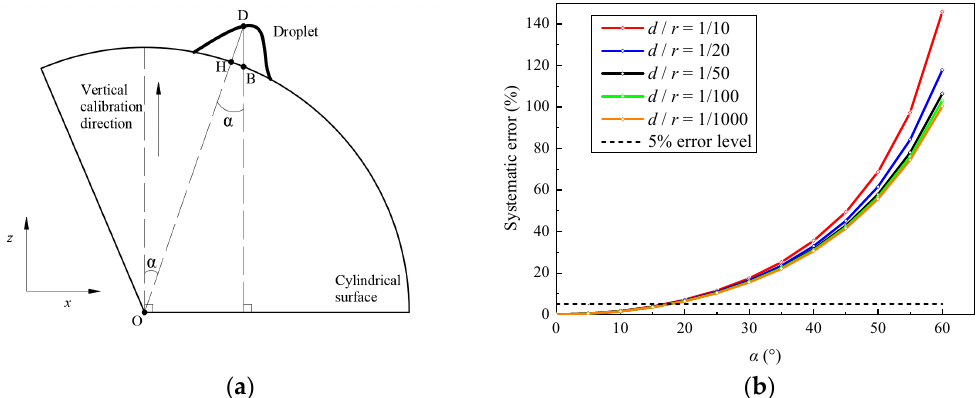
Figure 2. Schematic diagram of ( a ) a droplet on the cylindrical surface and ( b ) dependence of the systematic error on α for different d / r .